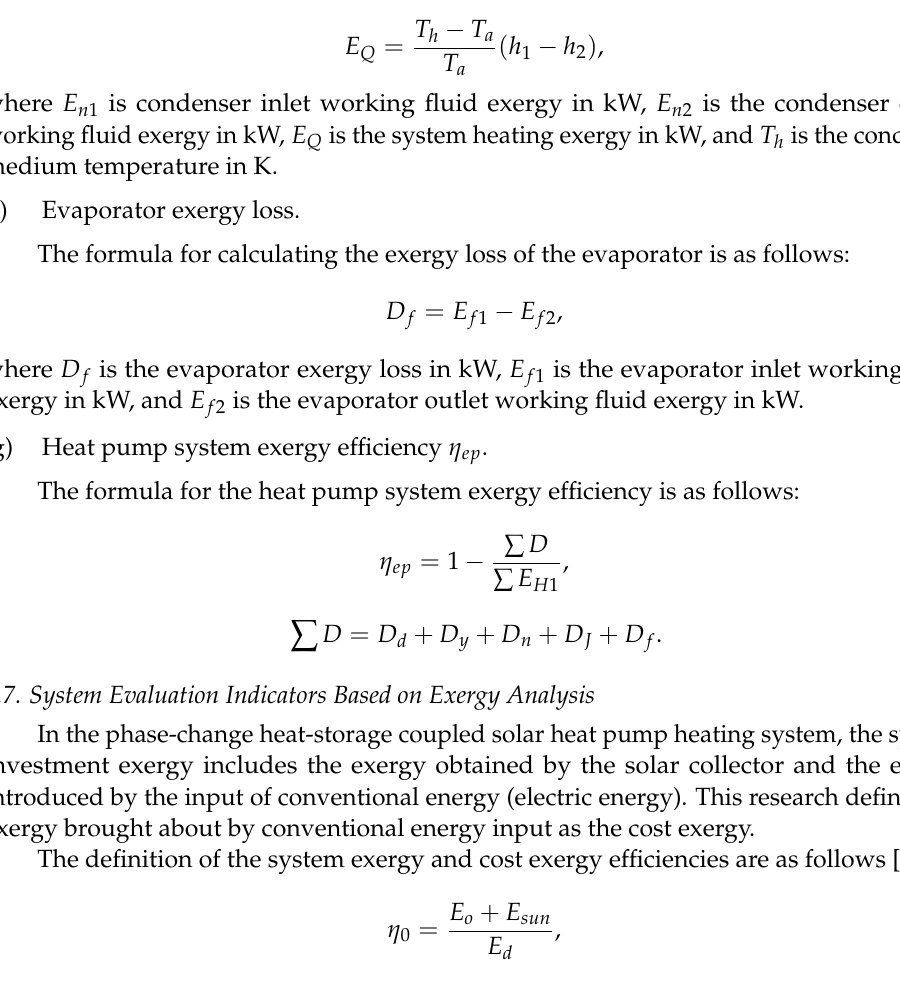
Figure 3. Schematic diagram of the condenser tritium balance model.